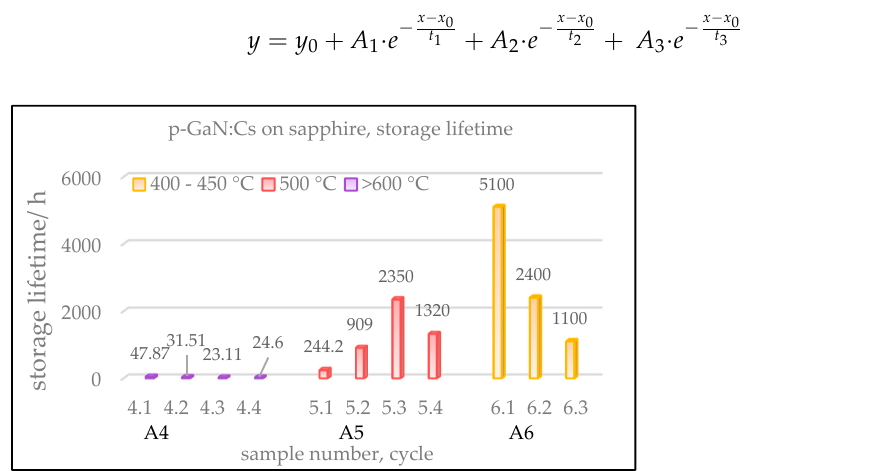
Figure 5. Extrapolated storage lifetimes of p-GaN:Cs on sapphire photocathodes, influenced by the cleaning temperature. The numeration of samples is the same as in Figure 4. Equation (2) was used for the extrapolation of the lifetimes.